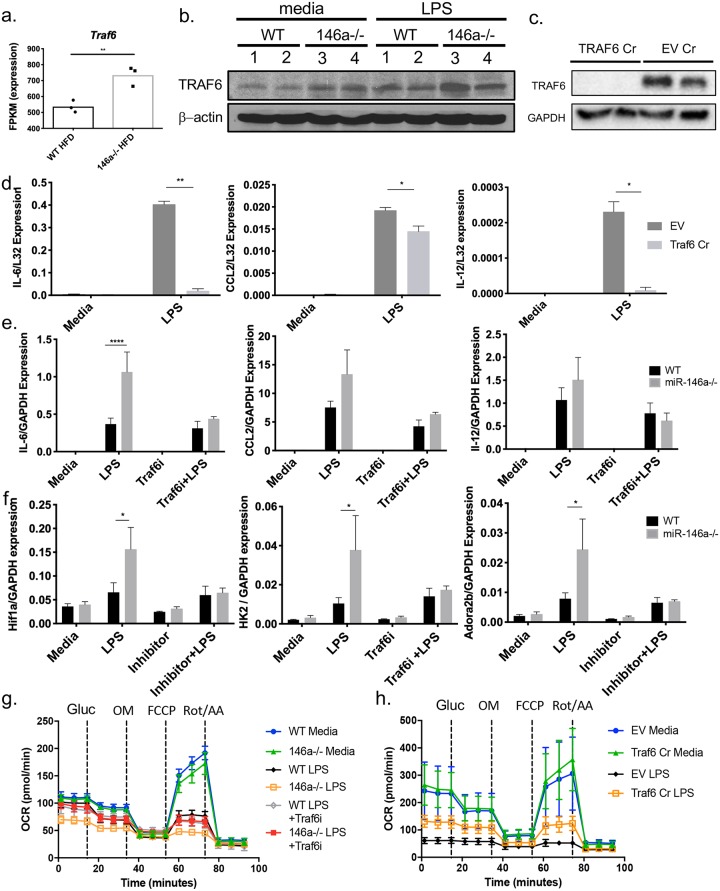
The miR-146a target Traf6 downregulates inflammation and alters cellular metabolism in activated macrophages.(A) FPKM values of Targetscan-predicted miR-146a-5p target Traf6 in WT or miR-146a-/- ATMs during HFD, as determined by RNA-seq. (B) Western blot for Traf6 and beta-actin in lysates from WT (1 and 2) or miR-146a-/- (3 and 4) BMDMs double-stimulated with media control or LPS. (C) Western blot for Traf6 and GAPDH in lysates from Traf6 CRISPR and Empty Vector control RAW cells stimulated with media control or LPS. (D) mRNA expression of il6, ccl2, and il12 in Traf6 Cr and EV (empty vector) control RAW cells. (E) mRNA expression of Il6, Ccl2, and Il12 in WT or miR-146a-/- BMDMs treated with media, LPS, Traf6i, or Traf6i+LPS. (F) mRNA expression of metabolic genes Hif1a, Hk2, and Adora2b in WT or miR-146a-/- BMDMs double stimulated with media, LPS, Traf6i, or Traf6i+LPS. (G) OCR of WT and miR-146a-/- BMDMs double-stimulated with media, LPS, Traf6i, or Traf6i+LPS, followed by Seahorse analysis with addition of glucose (gluc), oligomycin (OM), FCCP, and rotenone (rot)/antimycin A (AA). (H) OCR of Traf6 Cr and EV control RAW cells double-stimulated with LPS or media, followed by addition of glucose (gluc), OM, FCCP, and Rot/AA. Data are shown as mean±SEM (d-f) or as individual mice (a-b). p-values were calculated using two-tailed Student’s t-test. *p<0.05; **p<0.01; ***p<0.001; ****p<0.0001.